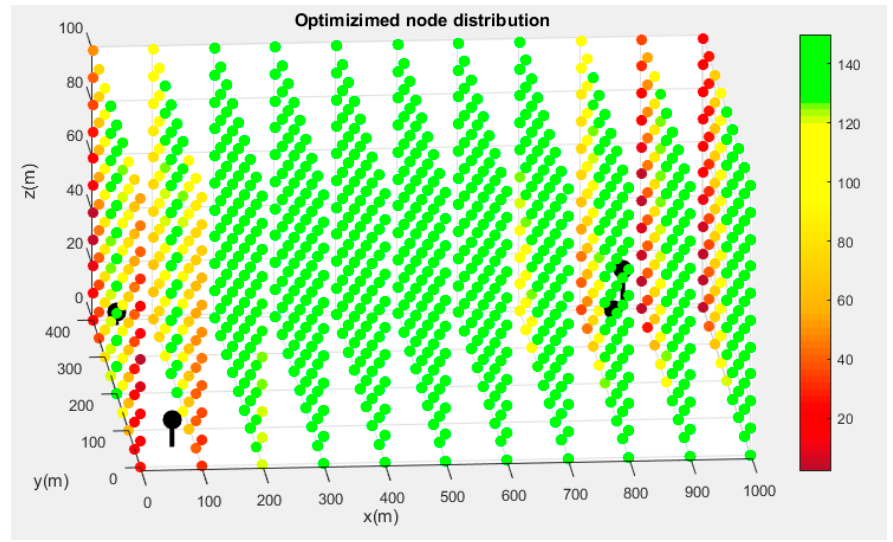
Figure 7. Evaluation of the convergence radius in the coverage area for the optimized distribution. Table 2. Statistical parameters of the optimized and random